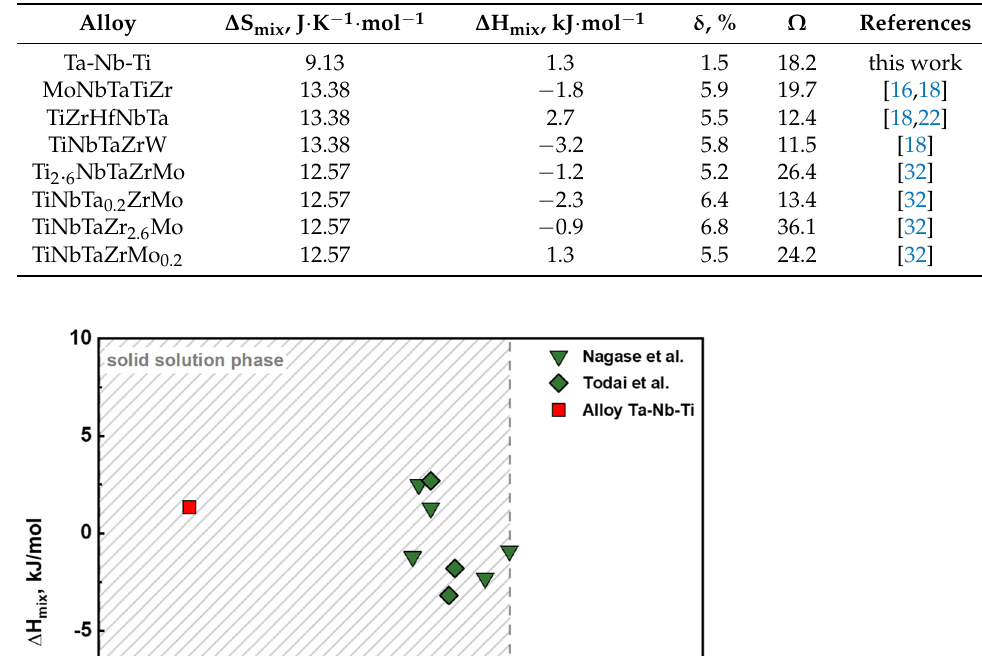
Table 1. Results of the thermodynamic and geometrical calculations of alloy Ta-Nb-Ti, using the equations presented in [24–28] and comparison with other high-entropy alloys for potential biomedical use.